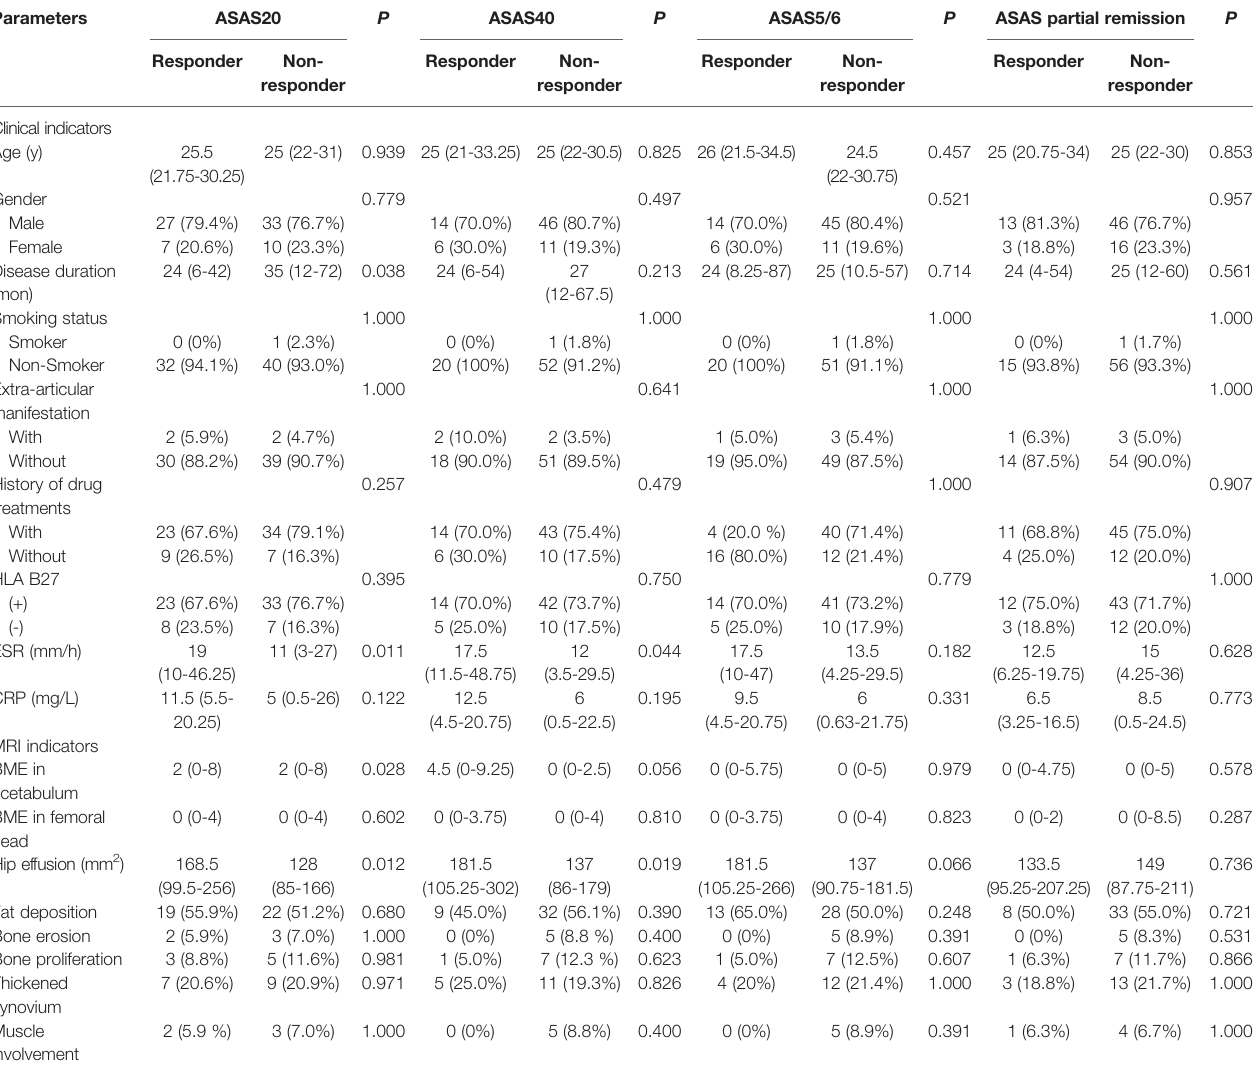
TABLE 3 | Comparison of clinical and MRI indicators of treatment responders and non-responders.